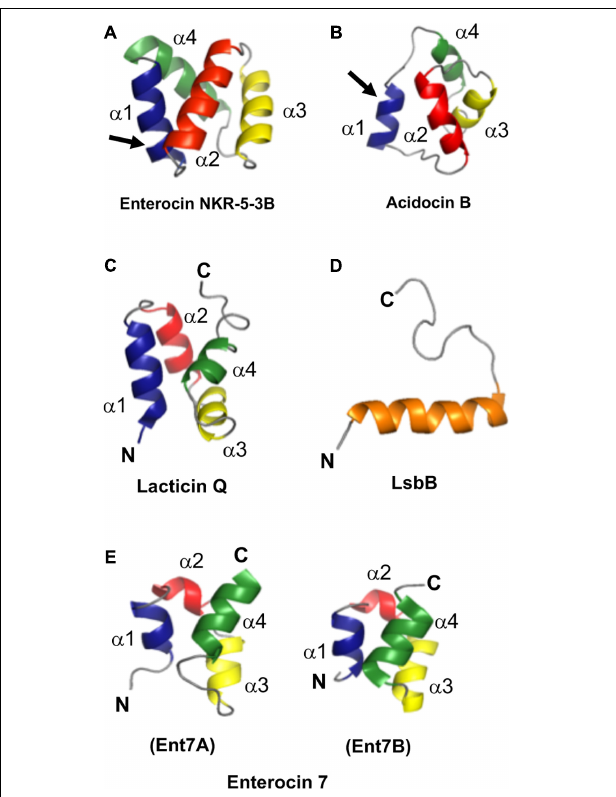
FIGURE 5 | Cartoon representation of the structures of the representative sub-groups of circular and leaderless bacteriocins. (A) enterocin NKR-5-3B represents the saposin fold exhibiting circular bacteriocins or group i, (B) acidocin B represents the helical bundle structure exhibiting circular bacteriocins or group ii, (C) lacticin Q represents the saposin fold exhibiting single peptide leaderless bacteriocins, (D) LsbB represents the single helical structure exhibiting single peptide leaderless bacteriocins, and (E) enterocin 7, composed of enterocin 7A and 7B, represents the saposin fold exhibiting two-peptide leaderless bacteriocins. N- and C-terminal ligation site of the circular bacteriocins is indicated by arrow whereas the terminal ends of leaderless bacteriocins are indicated by letters N and C. In order to depict directionality, helices of each bacteriocins are numbered accordingly. Images are rendered using PyMol Molecular Graphics